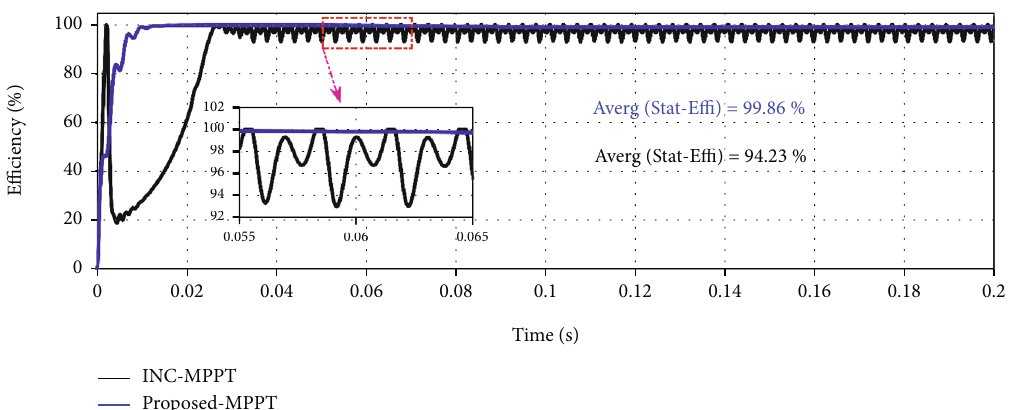
Figure 10: Simulation results of tracking e ffi ciency under STC.